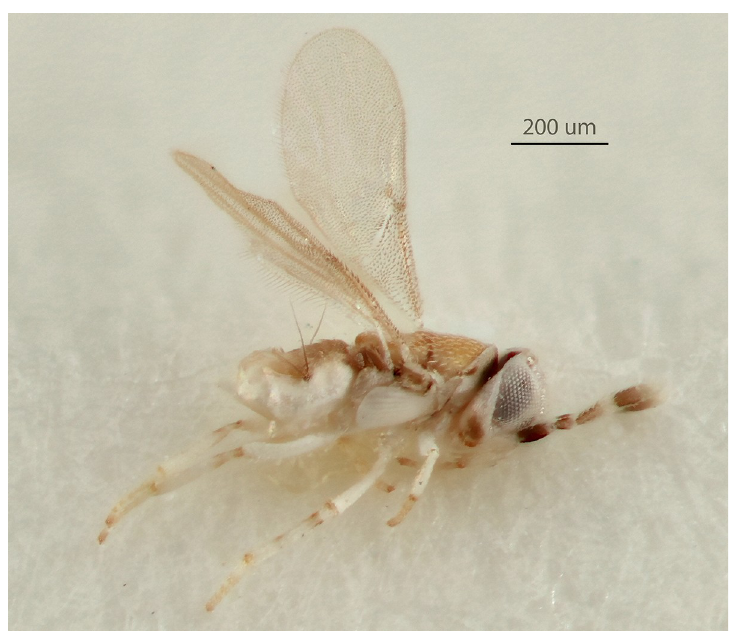
Fig 1. Metaphycus macadamiae female holotype, habitus (photo by N. Dale-Skey–specimen subsequently slide- mounted).